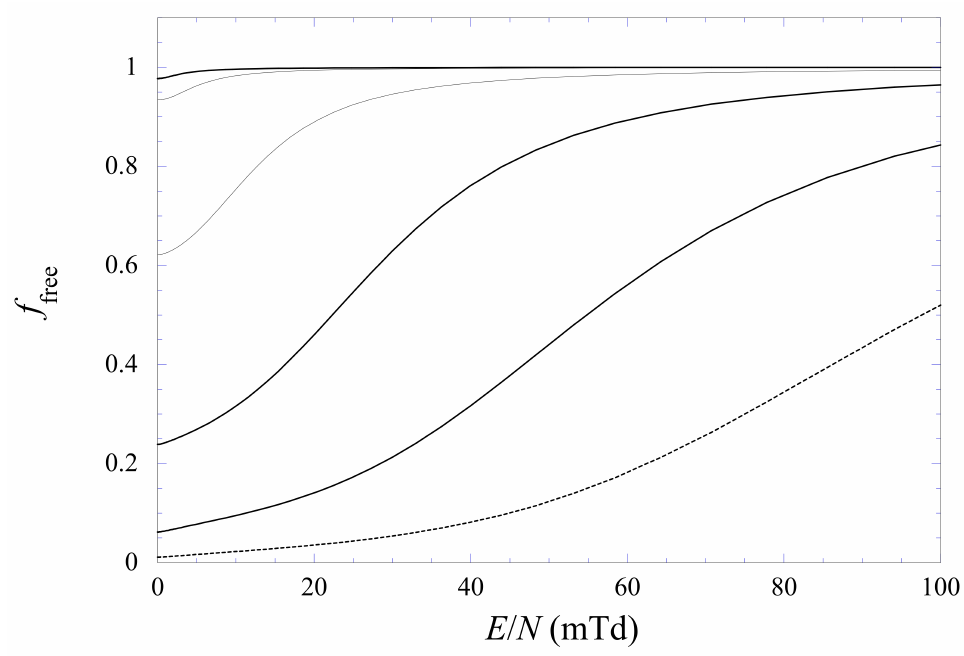
Figure A2. f free as a function of E / N at T = 26.1 K. From top: N : 5, 10, 20, 30, 40, 50 (in units of 10 26 m − 3 ). Note that for T = 26.1 K, the threshold density is N th & 20. At a low density, f free is practically always equal to 1. Upon increasing N , f free steadily